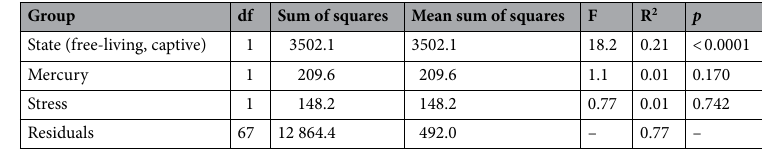
Table 3. Results of PERMANOVA using a Euclidean distance matrix to test for differences in uropygial gland microbiota among free-living and captive song sparrows and with dietary treatment while controlling for bird ID to account for birds that were sampled twice: an initial (free-living) sample collected on the day of capture and a captive sample collected after approx. 11 months in captivity.